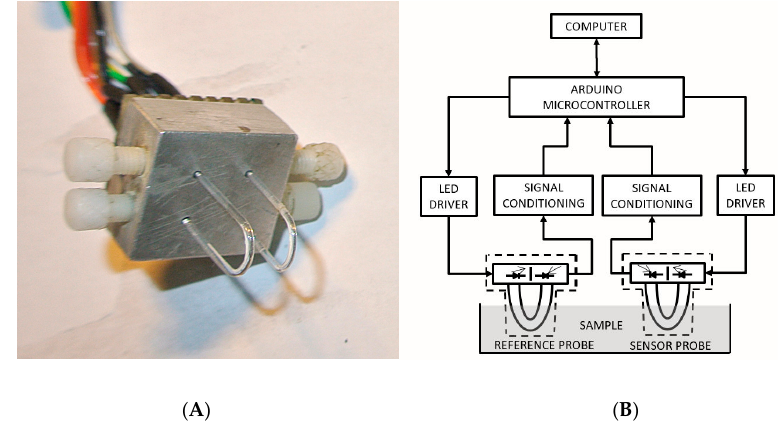
Figure 1. ( A ) Sensor head with two sensors, the reference and the functionalized with antibody. ( B ) Schematic diagram of the optoelectronic setup.